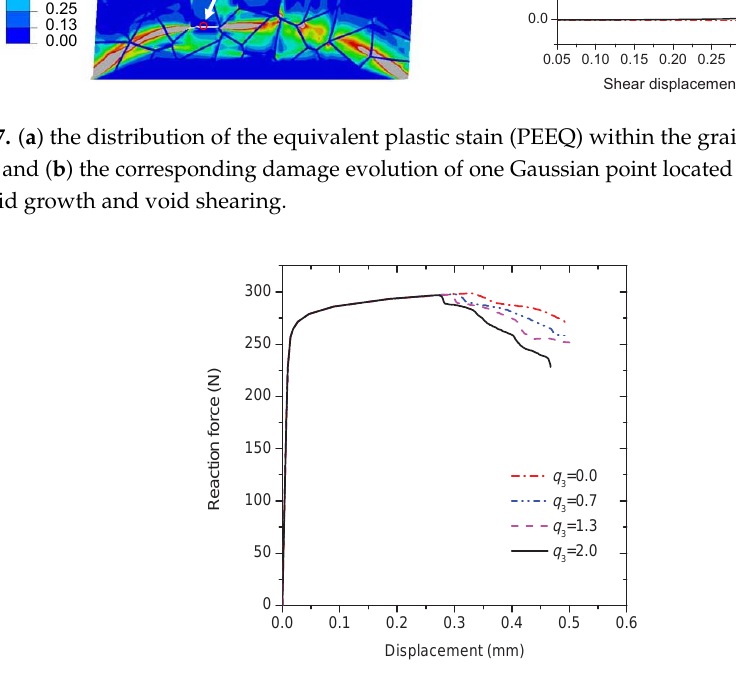
Figure 8. The reaction force versus the applied displacement curves of the RVE under the shear loading for different values of q 3